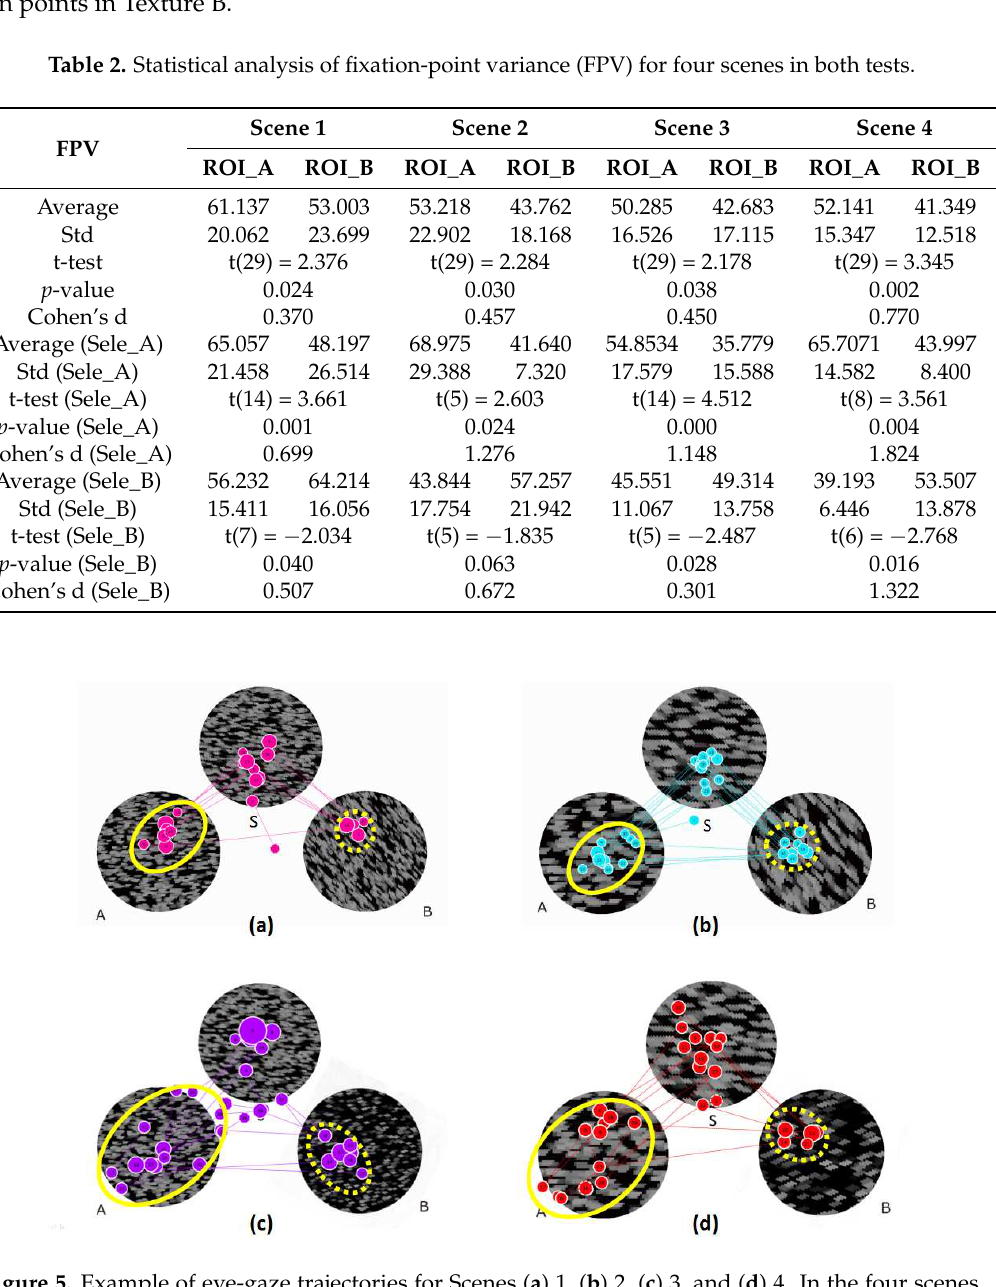
Figure 5. Example of eye-gaze trajectories for Scenes ( a ) 1, ( b ) 2, ( c ) 3, and ( d ) 4. In the four scenes, fixation points were more dispersed in Texture A than in Texture